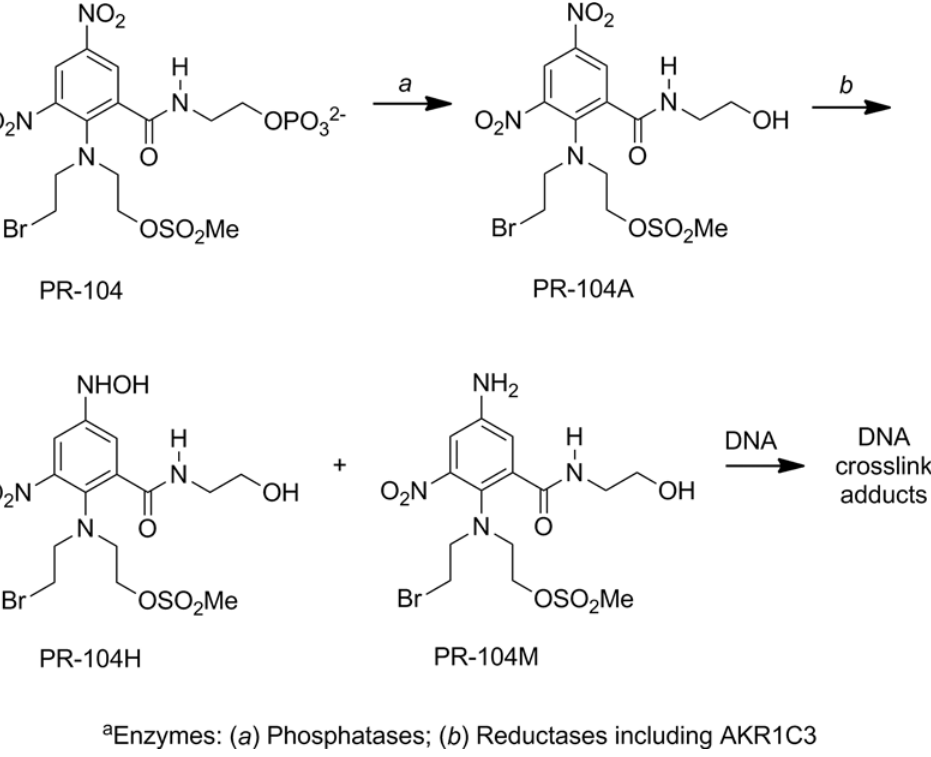
Fig 1. Activation of the bioreductive prodrug PR-104A, a metabolite of the dinitrobenzamide mustard pre-prodrug PR-104, by aromatic nitro- reduction. In vivo , PR-104 is hydrolyzed to PR-104A, which is further reduced to metabolites that form cytotoxic ICLs.